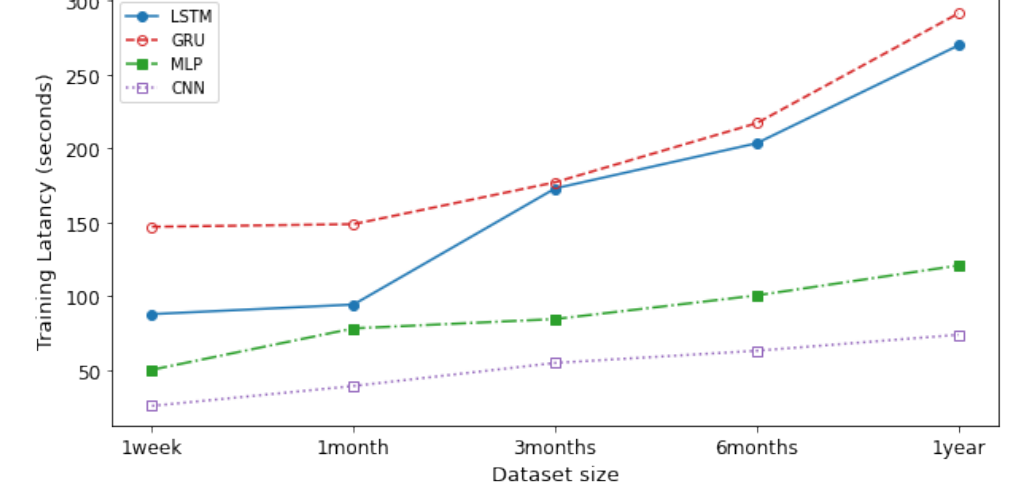
Figure 11. Comparison of NTPA training latency.